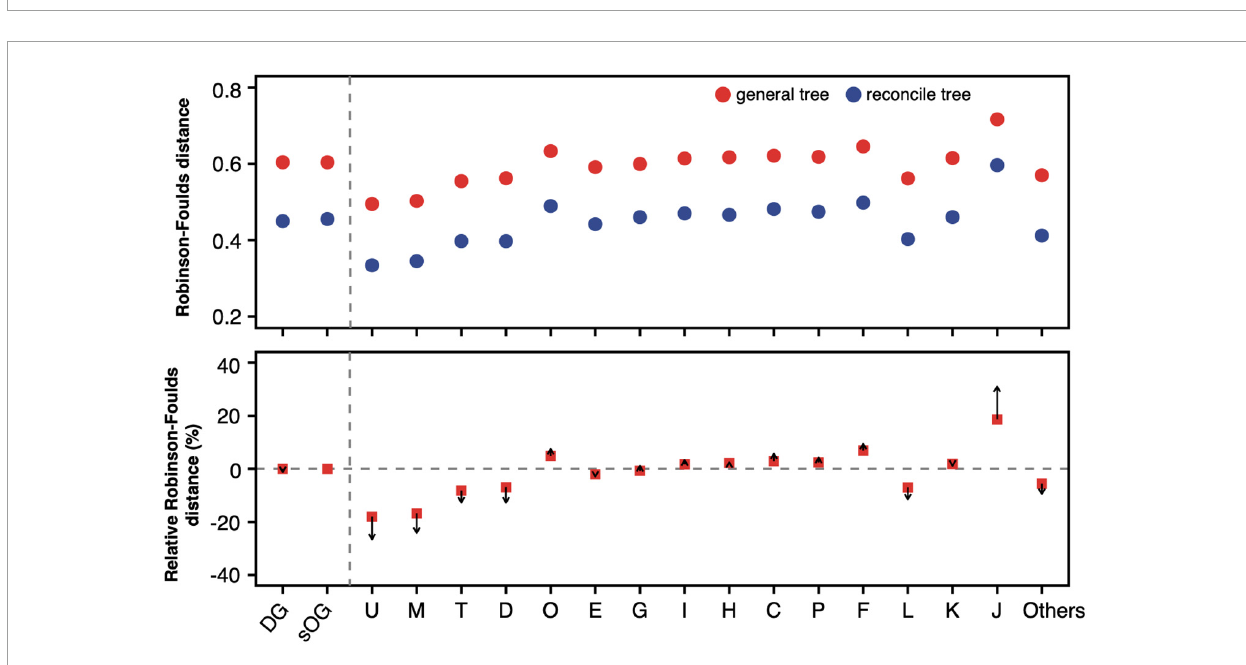
FIGURE5 Robinson-Foulds distance of general gene tree and reconciled gene tree to supermatrix (ST1). For a gene dataset, 100 mean values of Robinson-Foulds (RF) distances from 100 random genome datasets (RGDs) were averaged and shown in the (upper panel) . Red solid circles represent the average RF distance of general gene trees to ST1, and solid blue circles represent the average RF distance of reconciled gene trees to − RF tsOG → ST1 , where t J is general gene tree of the gene in Clusters of Orthologous ST1. The relative RF distance was calculated as formula, RF tJ → ST1 RF sOG → ST1 Genes (COG) J. In the (lower panel) , arrows start from the relative RF distance of general gene trees and point to the relative RF distance of reconciled gene